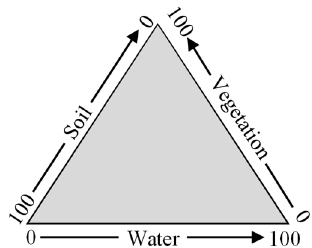
Figure 4. The scheme for linear spectral mixture of three dominant endmembers of the land surface (i.e., water, vegetation, and soil). Each point inside the triangle represents a possible combination of fractions; adapted from Ji et al. [31].